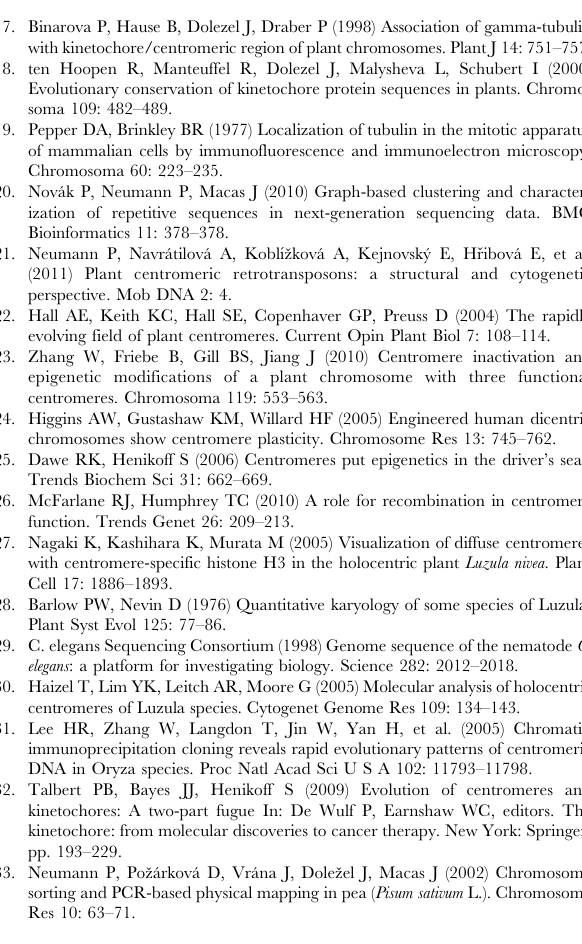
Table S1 Size estimation of regions delimited by the most distant CenH3-containing domains. Video S1 Animation of a FIB/FESEM series of SEM micro- graphs (1 kV, signal ratio 30% SE and 70% BSE) showing sequential images of milled surface revealing the exposed centromere interior. The series is of 124 images acquired after sequential 5 nm milling